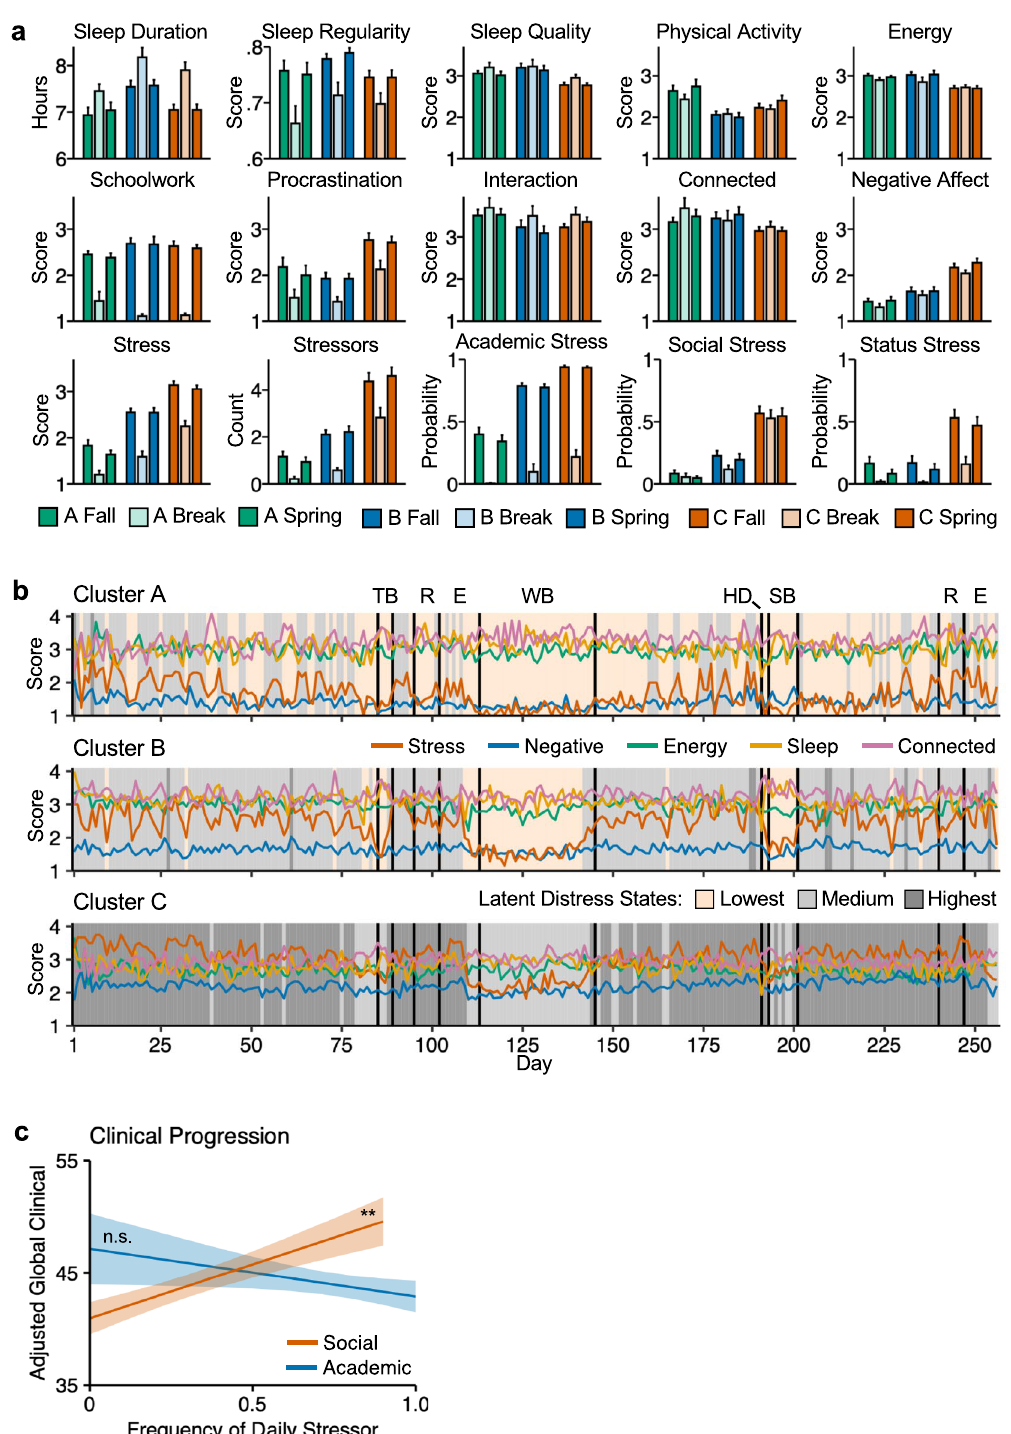
Figure 6. The three student profiles show distinct distress dynamics. ( a ) Bar plots show between-person means of each variable separately by student profile and by term. Error bars represent standard errors of the mean. ( b ) Sequence of most likely latent states of Distress for the three student profiles. TB thanksgiving break, R reading period, E exams period, WB winter break, HD housing day, SB spring break. ( c ) Frequency of Social stressors, but not Academic stressors, prospectively predicts subsequent global clinical symptoms. **Statistical significance at p < 0.01, n.s. not statistically significant (p >